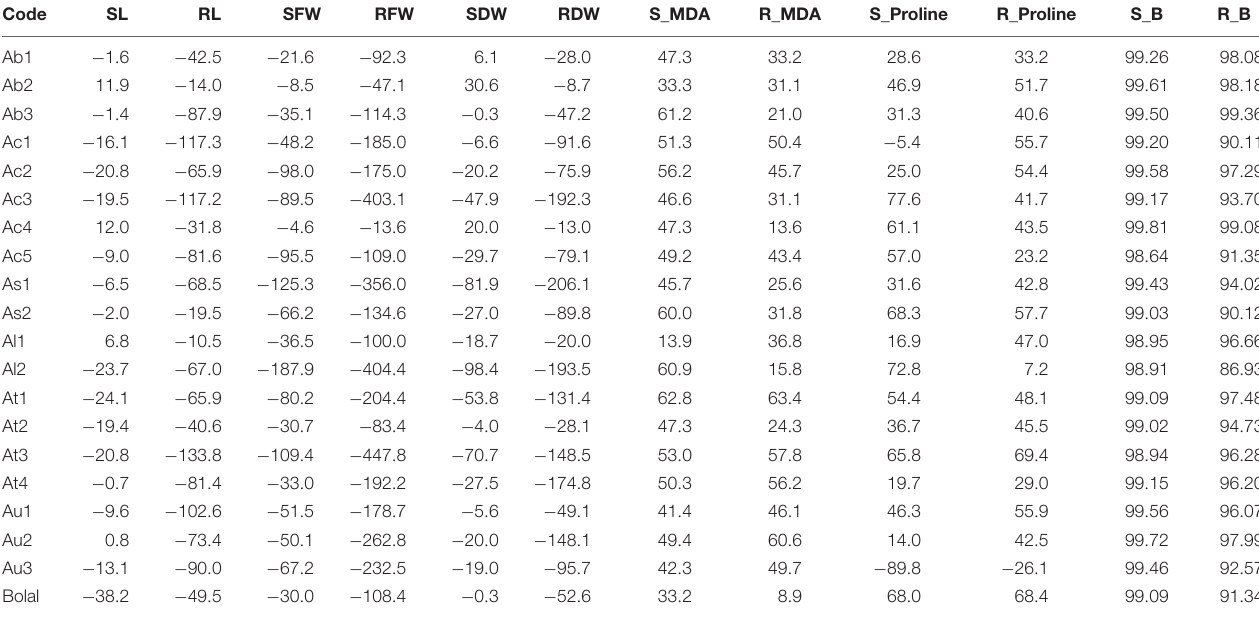
TABLE 3 | The percentage change in the studied traits of 19 Aegilops accessions and the B-tolerant check cultivar, Bolal 2973 is highly toxic B (10 mM B) treatment as compared to Control.